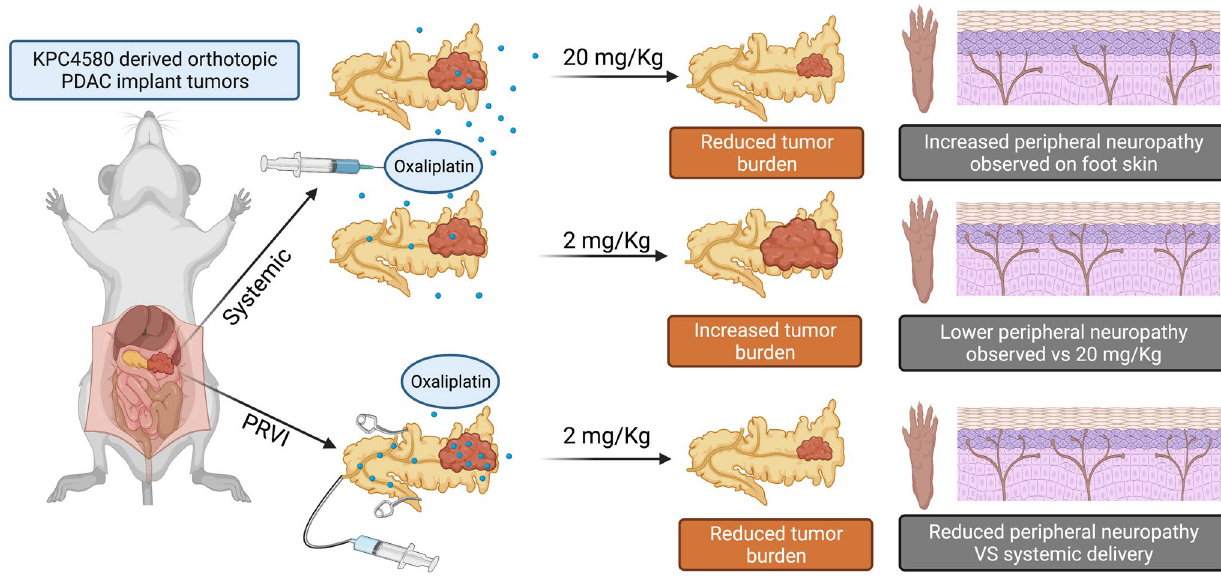
Fig. 4 Schematic representation of the study design and outcome, created with BioRender.com. This study demonstrated that PRVI deliv- ery of oxaliplatin achieved similar tumor control to systemic delivery with a tenfold lower dose (2 vs. 20 mg/kg). Peripheral neuropathy increased with greater systemic exposure to oxaliplatin. The risk of peripheral neuropathy can therefore be minimized with the lower thera- peutic dose of